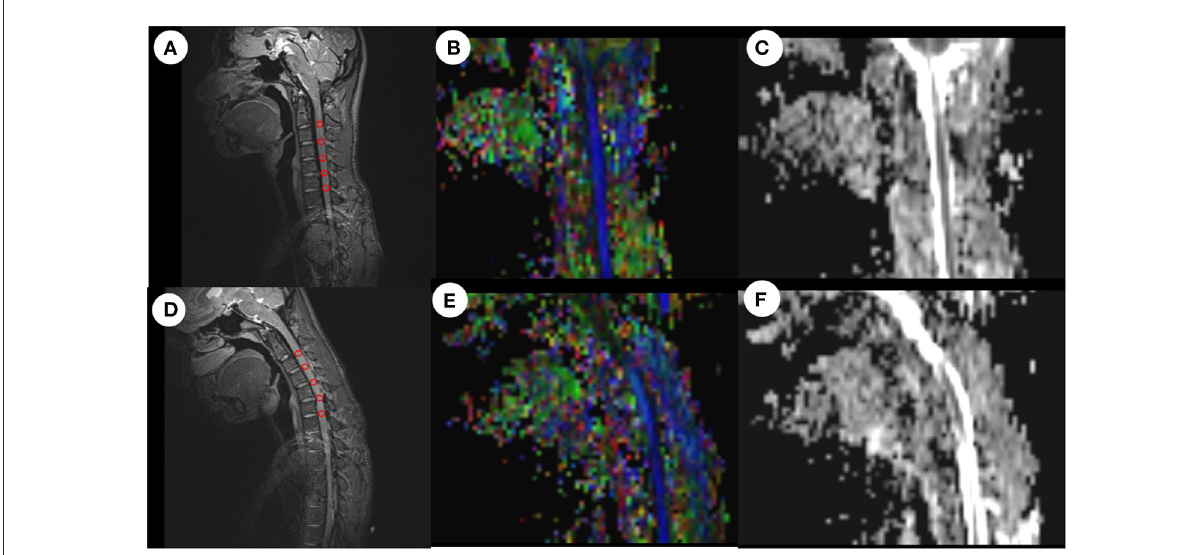
FIGURE2 ROI-based measurement of FA values and ADC values in neutral and flexion positions. After drawing a ROI on the anatomical image, the system automatically calculated the mean FA value and mean ADC value for all voxels in the ROI. (A) Anatomical image in the neutral position. (B) FA image in the neutral position. (C) ADC image in the neutral position. (D) Anatomical image in the flexion position. (E) FA image in the flexion position. (F) ADC image in the flexion position. ROI, region of interest; FA, fractional anisotropy; ADC, apparent diffusion coefficient.